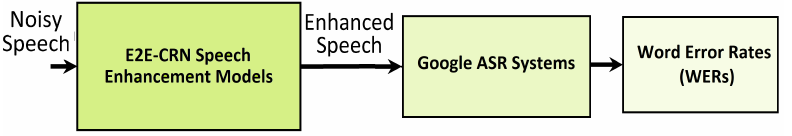
Figure 10. Google ASR system with Speech Enhancement at Front-End.